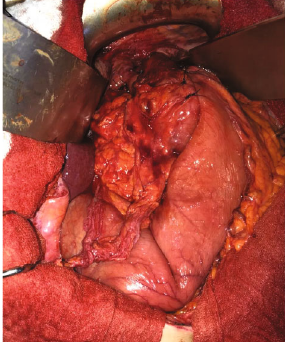
Figure 3: Closing of the hiatal ori fi ce and performing a Toupet